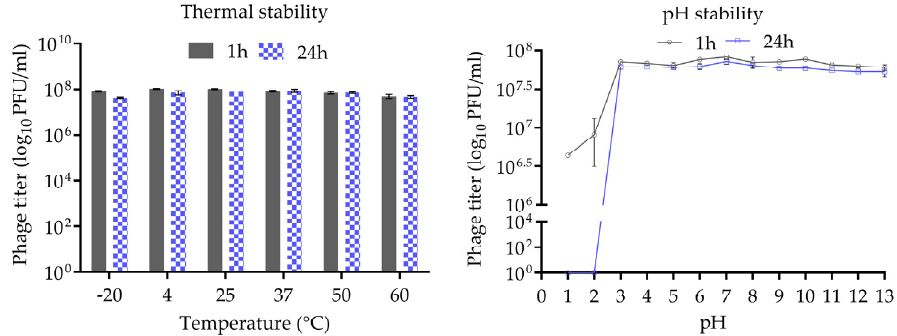
Figure 3. Thermal and pH stability test of CUB19. Error bars represent standard deviations.